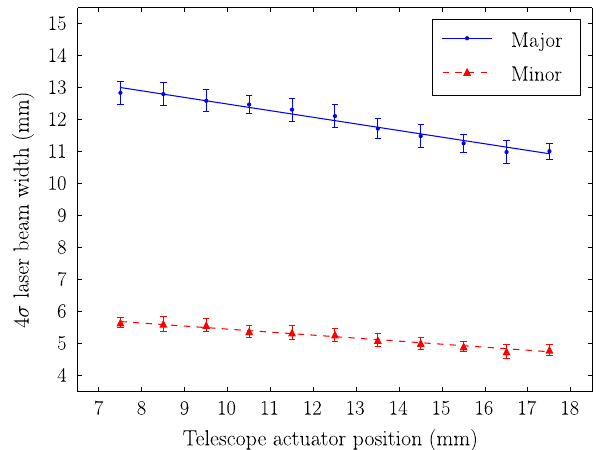
FIG. 9. 4 σ widths of the major and minor axes of the input laser beam profile as measured at the end of the laser diagnostic line as a function of telescope actuator position.